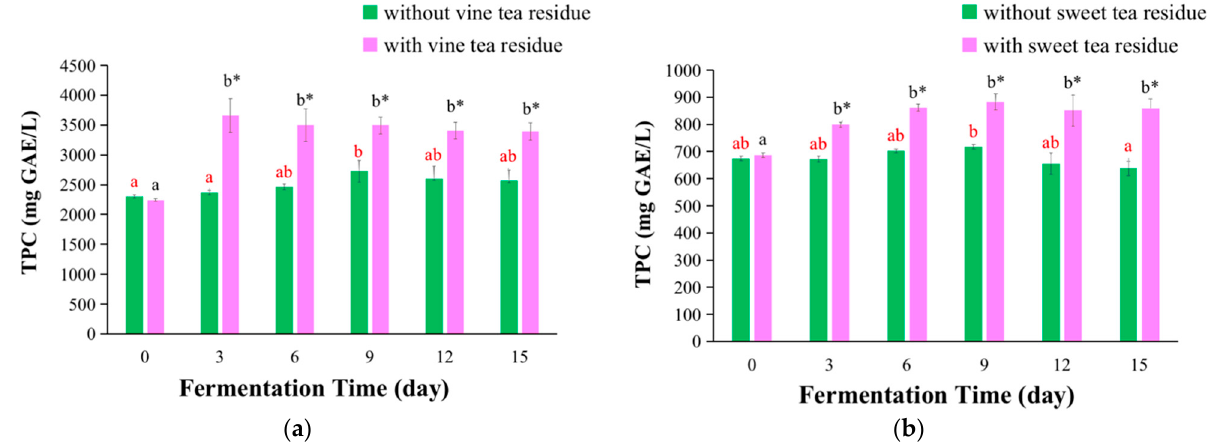
Figure 4. Changes of TPC values of kombucha beverages at different fermentation time. ( a ) TPC values of kombucha from vine tea; ( b ) TPC values of kombucha from sweet tea. The different red letters indicated that kombucha fermentation without tea residues at different fermentation time were significant differences ( p < 0.05), and the same red letter indicated no significant difference ( p > 0.05). The different black letters indicated that kombucha fermentation with tea residues at different fermentation time had significant differences ( p < 0.05), and the same black letter indicated no significant difference ( p > 0.05). * Indicated that there was a significant difference between the kombucha fermentation with tea residues and kombucha fermentation without tea residues at the same fermentation time ( p < 0.05).